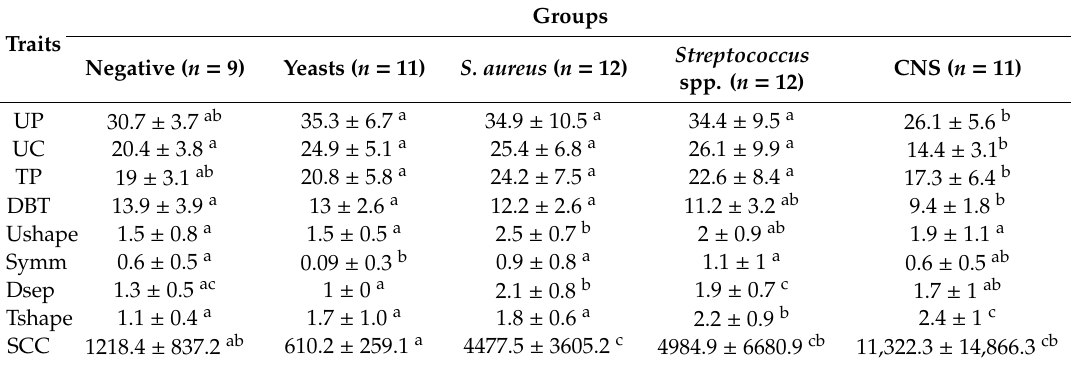
Table 3. Comparison of udder measured conformation traits (cm) and somatic cell count (SCC) and bacterial